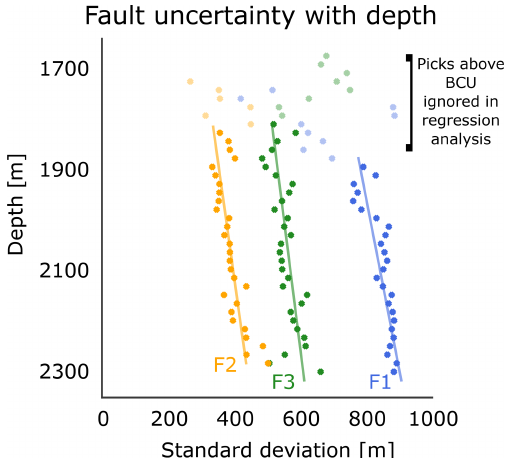
Figure 4. Scatter plot of mean (collapsed y axis) standard deviation along x axis of mean fault surfaces for Faults 1, 2 and 3. Chaotic patterns of uncertainty at shallow depths (faded data points) are likely due to sporadic numbers of interpretations, as students often stopped interpreting the faults before reaching the BCU. Overall, uncertainty of fault interpretations is increasing linearly with depth (linear regression only takes into account interpretations below the BCU; R values for Faults 1, 2 and 3, respectively: 0.75, 0.85 and